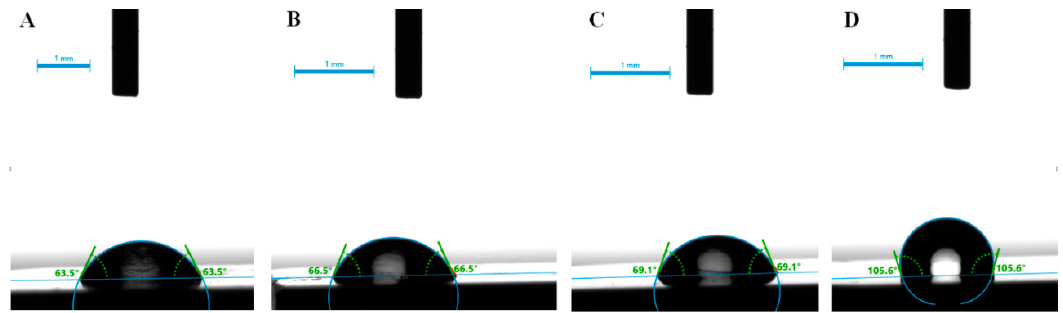
Figure 5. Representative pictures of water contact angle measurement on 60 nm ( A ), 96 nm ( B ), 149 nm ( C ), and 368 nm ( D ) silver nanoparticles modified titanium surface.